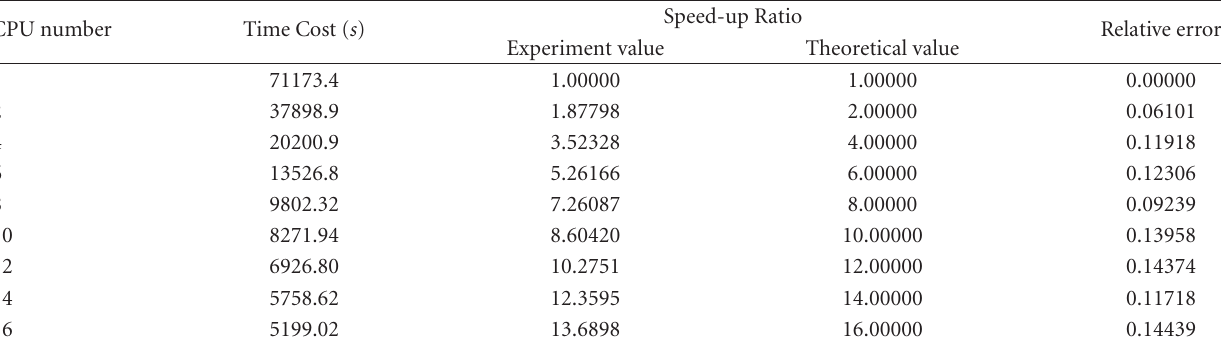
Table 2: Performance comparison between parallel framework with di ff erent number of CPUs and serial framework. Speed-up Ratio is defined as the ratio between the time cost of multi-CPUs simulation and that of single CPU simulation. Relative error is defined as | Experiment value − Theoretical value | / Theoretical